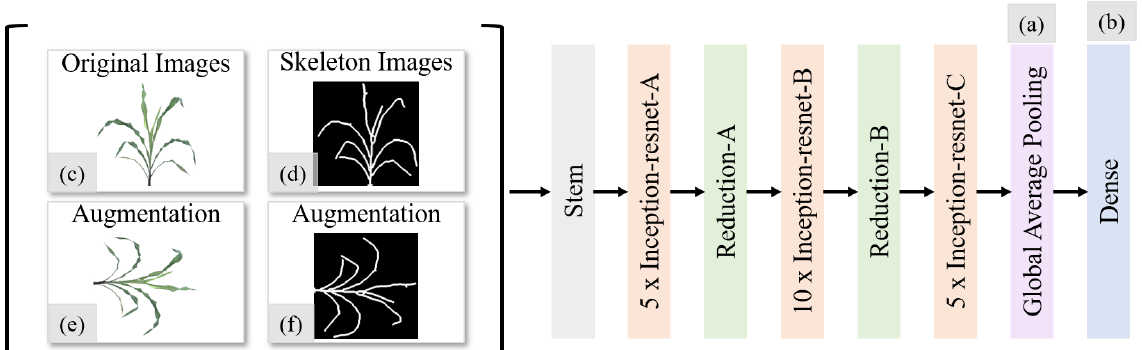
Figure 1. Our network architecture based on Inception-ResNet-v2 with main modifications: ( a ) global average pooling layer and ( b ) dense layer with one unit. The input to the network includes a combination of original images ( c ), skeleton images ( d ), and their augmentations ( e , f